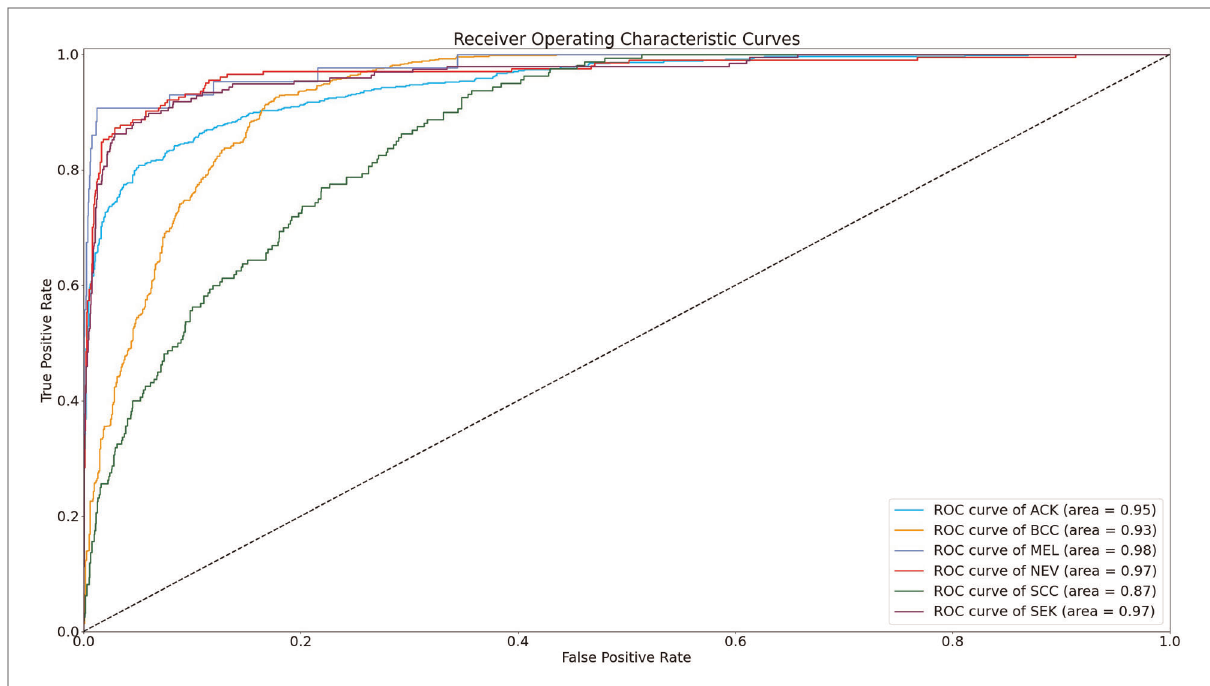
FIGURE 3 Receiver operating characteristic curves for different types of skin